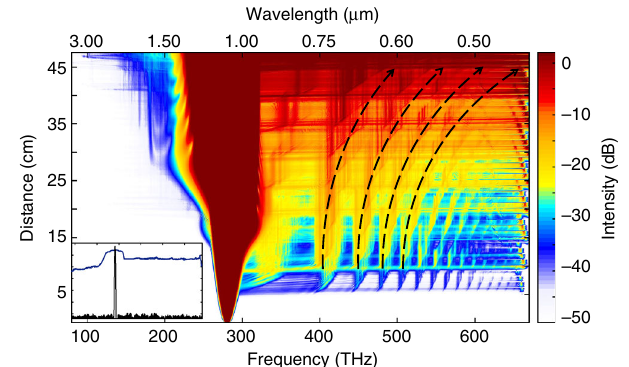
Fig. 9 Generalized Unidirectional Pulse Propagation Equation simulation of the spectral evolution in a tapered multimode fi ber when excited in the normal dispersion regime. A 0.5 m long multimode fi ber taper is excited with a 300 kW, 400 fs pulse, at 1064 nm. After only a few centimeters of propagation (~ 5 cm), a series of sidebands emerge. As the input pulse traverses the tapering section, an acceleration of intermodal collisions occurs. As a result, the newly generated sidebands drift away from the pump (dashed arrows), thus sweeping the entire spectrum. This leads to a fl at and uniform supercontinuum. The inset compares the spectrum of the input pulse (black) with the output supercontinuum